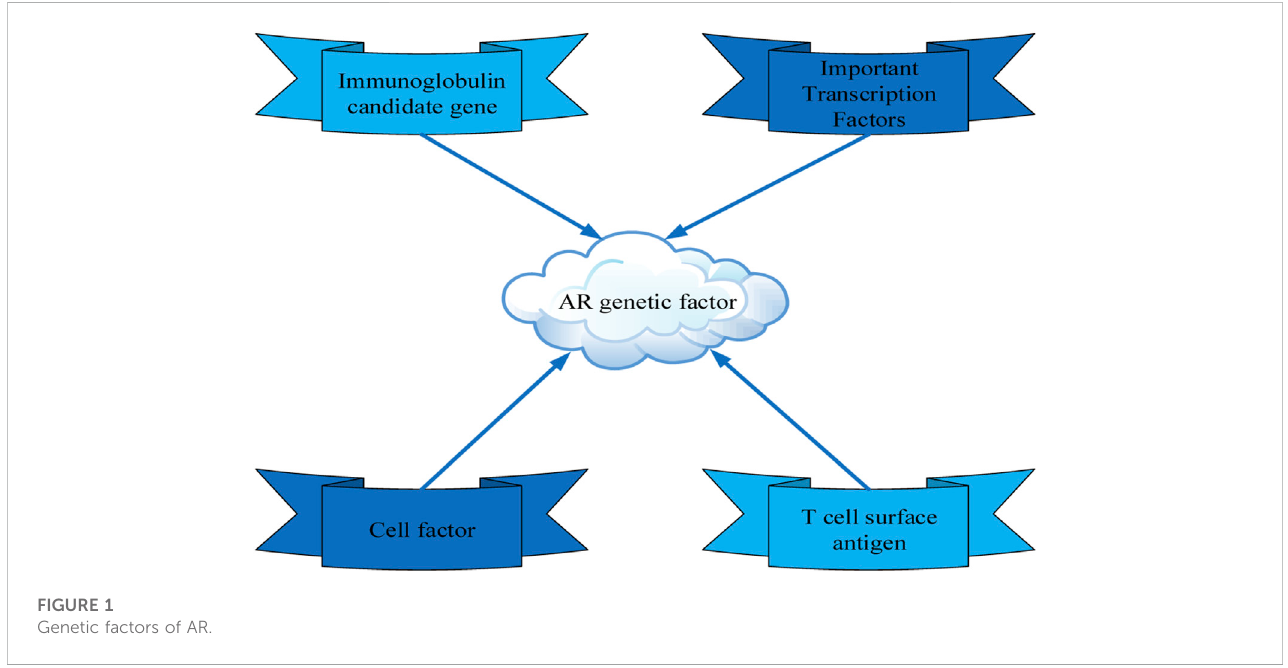
FIGURE 1 Genetic factors of AR.